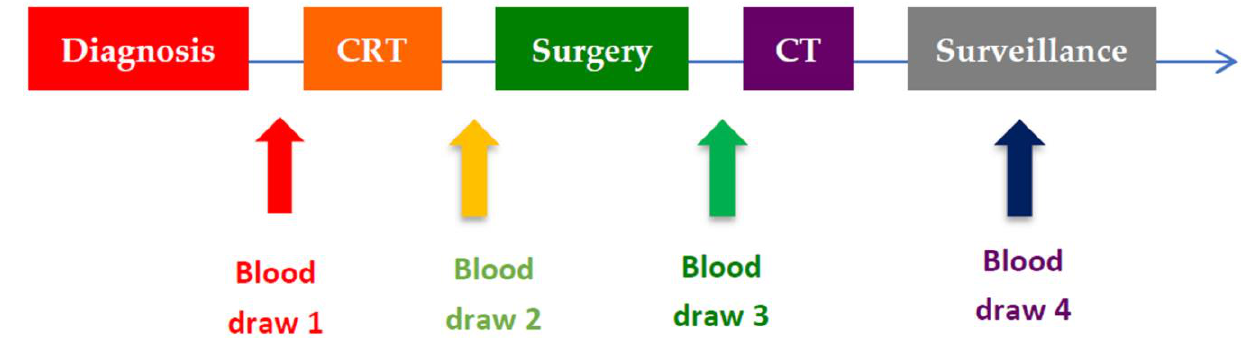
Figure 1. Timeline of blood draws. CRT: chemoradiotherapy; CT: chemotherapy. From each blood draw, the counts of leukocytes, neutrophils, monocytes, hemoglobin, and platelets were recorded. In addition, the neutrophil/lymphocyte ratio (NLR), the lymphocyte/monocyte ratio (LMR), and the platelet/lymphocyte ratio (PLR) were calcu- lated. From the basal analysis, the values of glucose, urea, creatinine, uric acid, sodium, potassium, triglycerides, cholesterol, LDH, GOT, GPT, bilirubin, alkaline phosphatase, ferritin, iron, calcium, total proteins, albumin, and CEA (carcinoembryonic antigen) before CRT were also obtained.